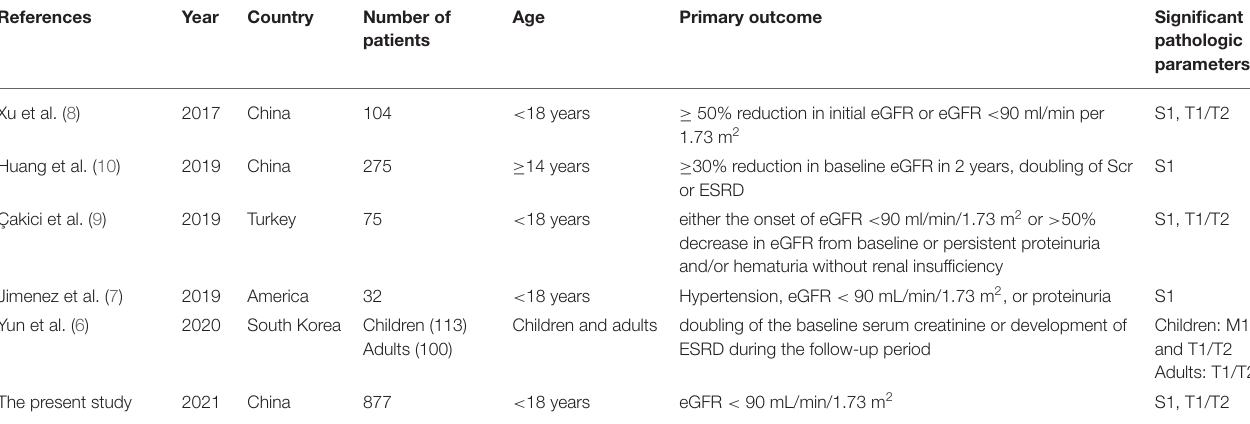
TABLE 5 | Summary of studies about application of Oxford classification to predict prognosis in children with